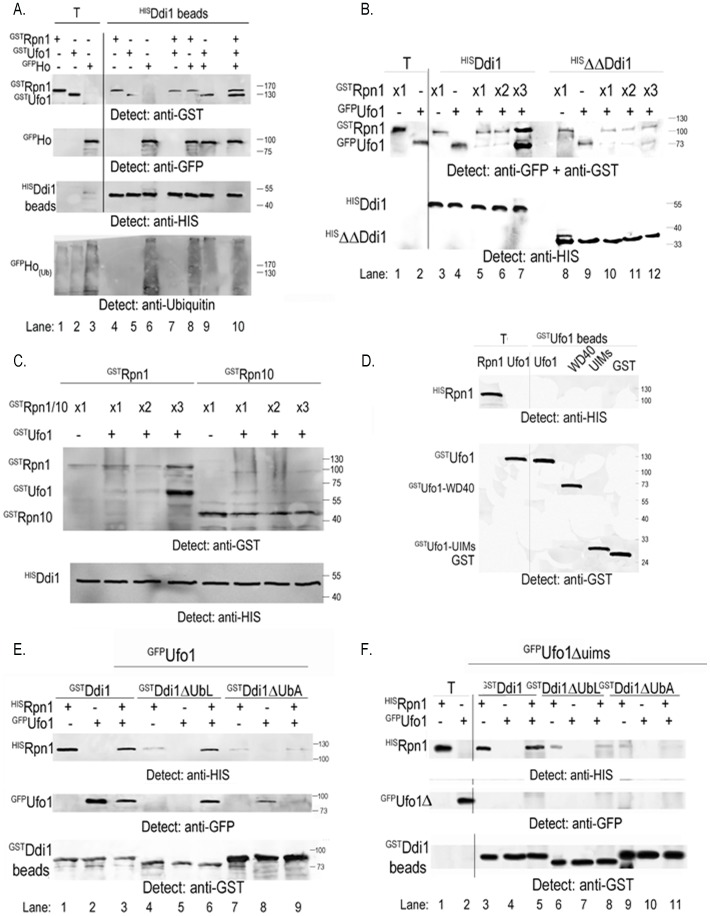
Rpn1 and Ufo1 exhibit synergistic binding to Ddi1.A. Bacterial lysate with GSTRpn1 or GSTUfo1 and yeast extract with GFPHo were incubated with HISDdi1 beads alone (Lanes 4–6), in pairs Lanes 7–9), or all three together (Lane 10). The bead fractions were analysed by Western blotting with anti-GST, anti-GFP, anti-HIS and anti-ubiquitin antibodies. Lanes 1–3 (T) show 10% of the lysate/extract for bead incubation. B. Yeast extract with GFPUfo1 was incubated with HISDdi1 and HISΔΔDdi1 beads in the absence or the presence of increasing amounts of HISRpn1. The bead fractions were analysed by Western blotting with anti-GFP, anti-GST antibodies and anti-HIS. Lanes 1 and 2 (T) show 10% of the lysate/extract with which the beads were incubated. C. Bacterial lysate with GSTUfo1 was mixed with increasing amounts of lysate with GSTRpn1 or GSTRpn10 and incubated with nickel beads with HISDdi1. The Western blots were analysed with anti-GST and anti-HIS antibodies. D. Bacterial lysate with HISRpn1 was incubated with GSTUfo1, the GSTUfo1-WD40 domain, the GSTUfo1-UIMs or control GST beads. The Western blots were analysed with anti-HIS and anti-GST antibodies. T indicates 10% of the lysate with which the beads were incubated. E. Recombinant HISRpn1 made in bacteria and GFPUfo1 from yeast extract were incubated alone or together with GSH beads bound to GSTDdi1, GSTDdi1ΔUbL, or GSTDdi1ΔUbA produced in bacteria. The bead fractions were analysed by Western blotting with anti-HIS and anti-GFP antibodies to show proteins that bound the GSH beads. The latter were detected with anti-GST antibodies. F. As above except that GFPUfo1Δuims was used instead of FL-Ufo1. T denotes 10% of the yeast extract incubated with the beads.